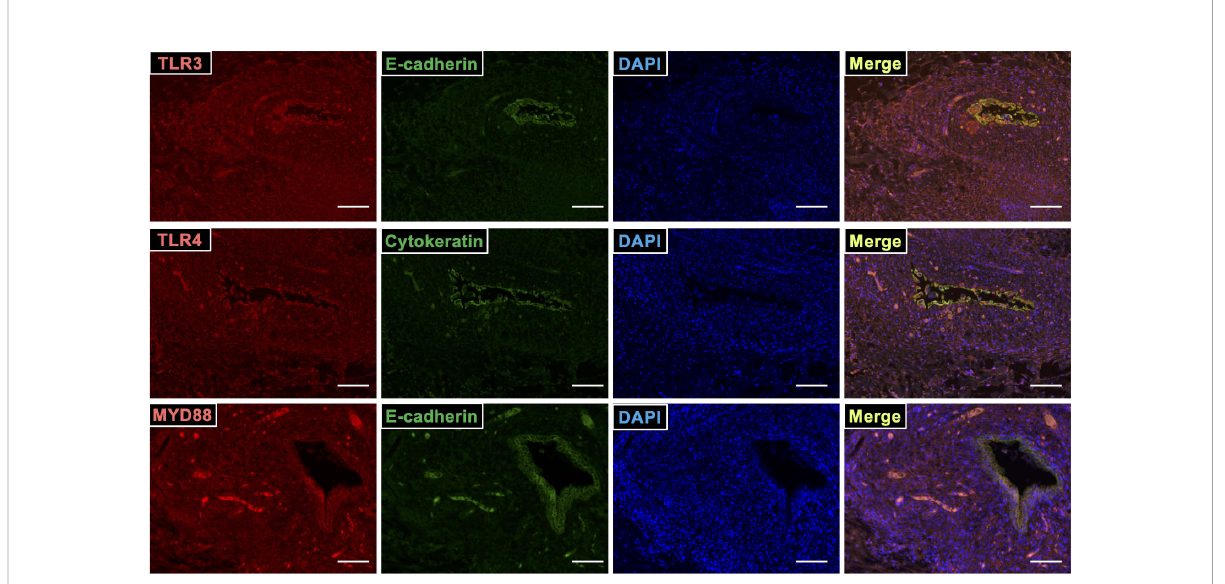
FIGURE 5 TLR3, TLR4, and MYD88 localized at ESCs in endometriosis lesion. Sections of endometriotic tissue were immunostained for TLR3, TLR4, MYD88 (red), and epithelial markers (E-cadherin and cytokeratin; green), and then counterstained with DAPI. Scale bar = 100 m